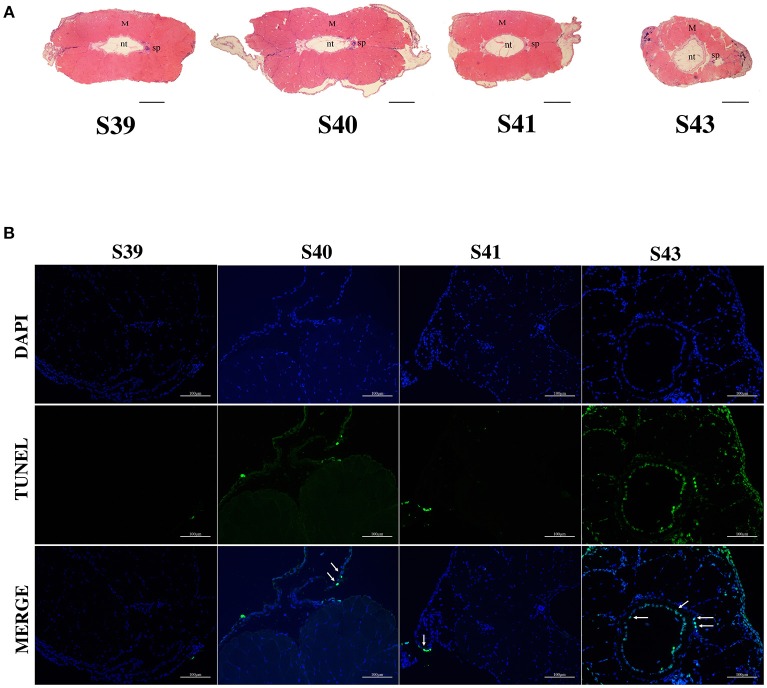
Extensive apoptosis in the epidermis and notochord is associated with tail resorption during natural metamorphosis. (A) H&E staining of tail cross-sections at indicated stages. Magnification, 40×, scale bar: 200 μm, M, muscle; nt, notochord; sp, spinal cord. (B) TUNEL labeling reveals apoptotic cells mainly in the epidermis and notochord at S43 when tail length reduces rapidly (see A). Tail sections at indicated stages were co-stained with TUNEL labeling (green) for apoptotic cells (indicated by white arrows) and DAPI (blue) for DNA. Magnification, 200×, scale bars: 100 μm.